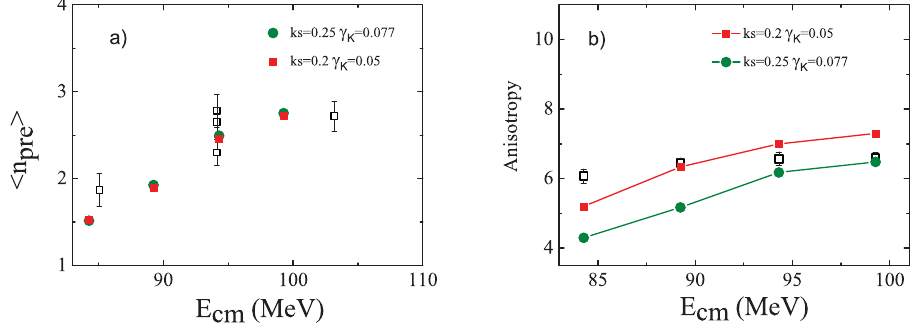
Figure 3. The prescission neutron multiplicity (a) and anisotropy of angular distribution (b) obtained for the 200 Pb. The open symbols are experimental data [22, 23], the filled circles are results of 4D calculations with k s = 0.25 and = 0.077(MeV zs) − 1 / 2 , the filled squares – 4D calculations with k (cid:1) K